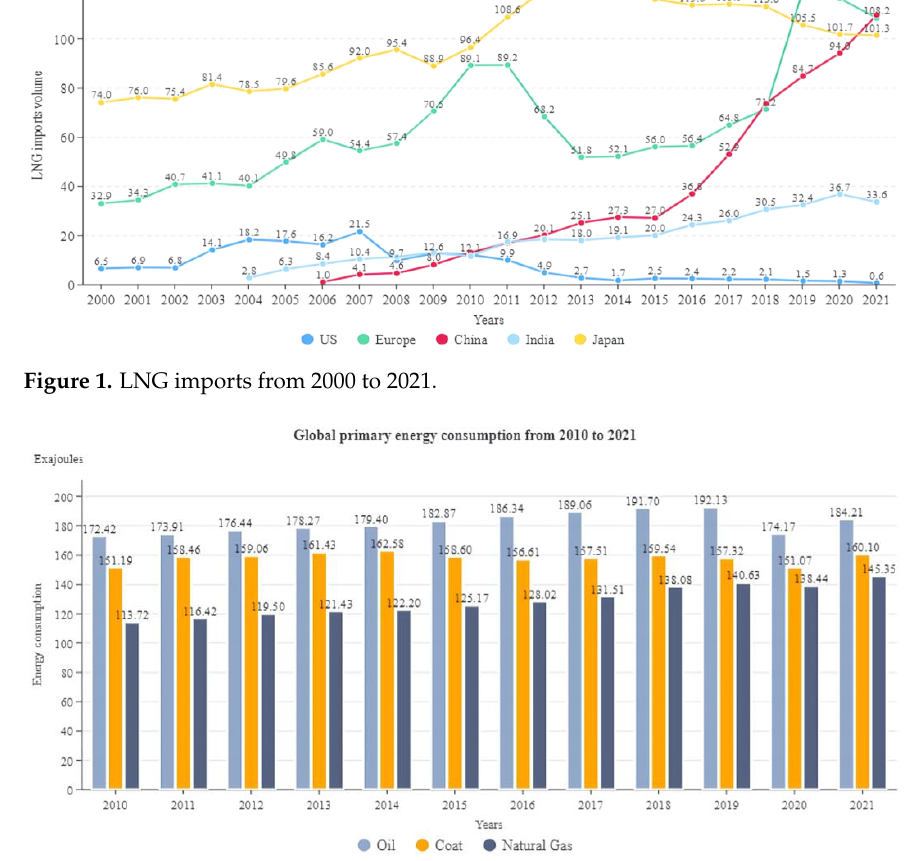
Figure 2. Global primary energy consumption from 2010 to 2021.